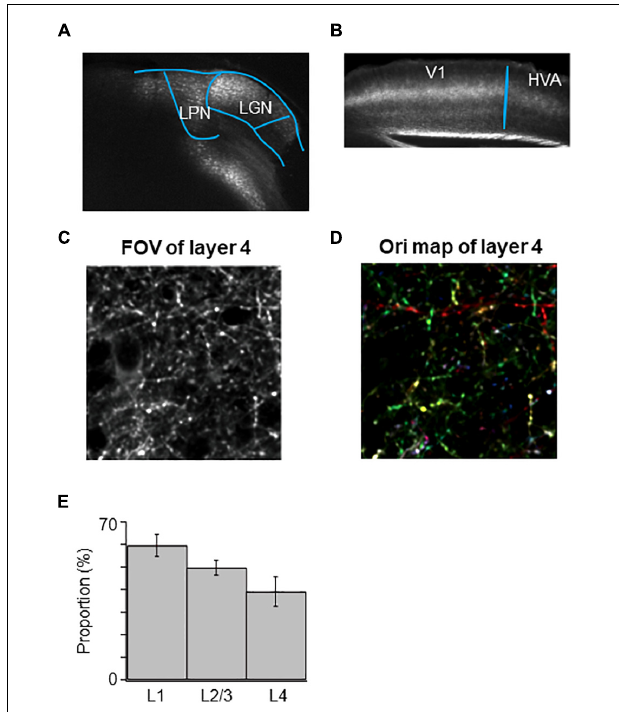
FIGURE 8 | High orientation selectivity of mixed LGN and LPN axons in V1. (A) Targeted expression of GCaMP6s to LGN was conducted but expression of GCaMP6s was leaked in LPN. (B) Projections of mixed LGN and LPN axons in V1. Projections can be seen not only in the V1 but also in the HVAs. (C) A FOV image of the mixed LGN and LPN axons in the layer 4 of V1. (D) An orientation color map of the mixed LGN and LPN axons in the layer 4 of V1. Mixed LGN and LPN axons in the layer 4 showed high orientation selectivity. (E) The proportion of orientation-selective mixed LGN and LPN boutons in layers 1 ( n = 941 boutons from 5 mice, 5 FOVs), 2/3 ( n = 1,106 boutons from 5 mice, 5 FOVs) and 4 ( n = 1,042 boutons from 5 mice, 5 FOVs). The proportion of orientation-selective mixed LGN and LPN boutons among different layers were statistically not different (between layers 1 and 4, p = 0.258; other pairs, p = 1, Mann–Whitney U -test with Bonferroni correction). LPN, lateral posterior nucleus; LGN, lateral geniculate nucleus; V1, primary visual cortex; FOV,